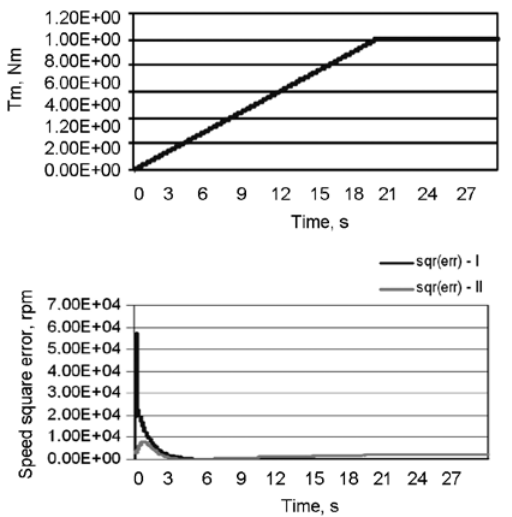
Fig. 5. Load torque T m and related square error ( sqr(err) ) of speed for estimation in system I/II respectively during launching hybrid process with the BLDC drive